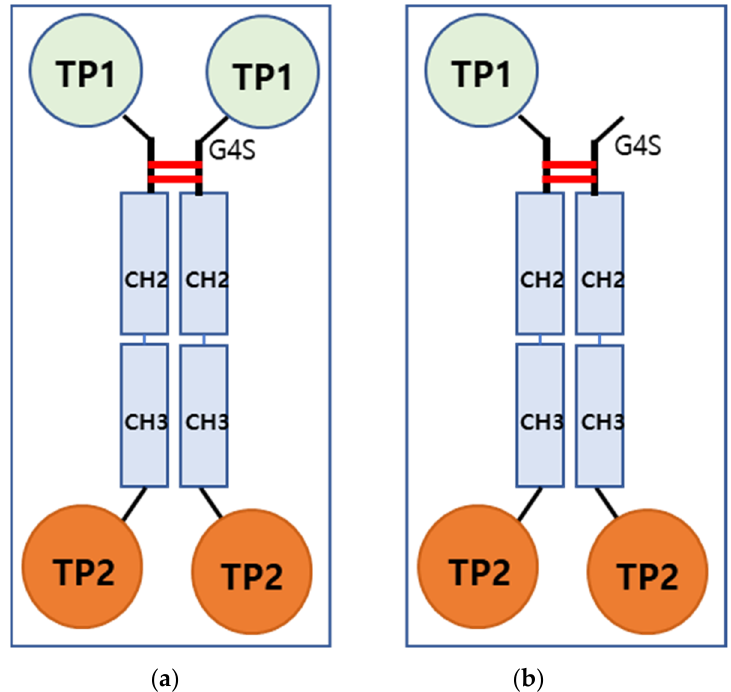
Figure 1. Schematic diagram of peptide Fc-fusion protein. ( a ) Molecule design for drug substance. ( b ) Low molecular weight (LMW) caused by molecule instability. TP1: target protein on the N-terminus side; TP2: target protein on the C-terminus side; CH2, CH3: constant domains of the antibody Fc fragment; G4S: peptide linker.